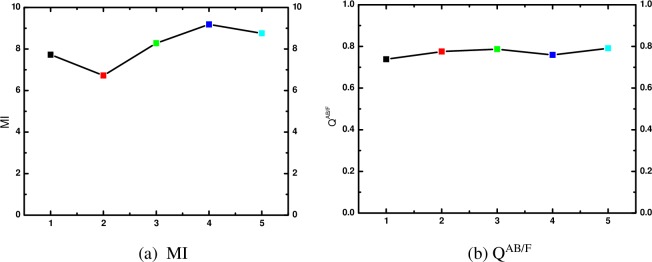
MI and QAB/F for ‘pepsi’ multi-focus images.